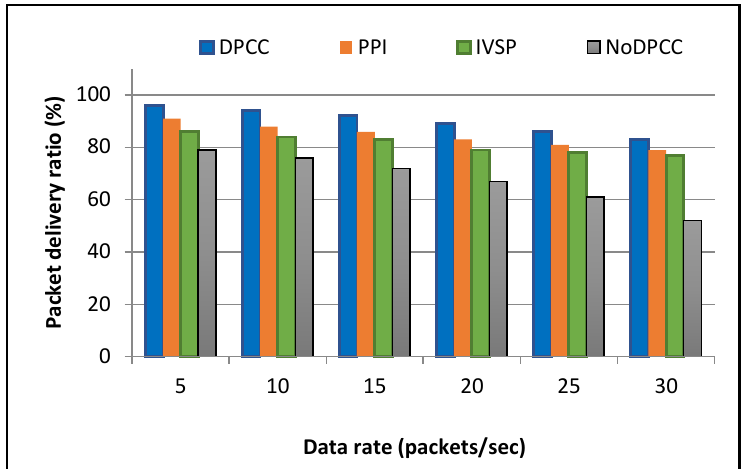
Figure 12. Packet delivery ratio vs. data rate.